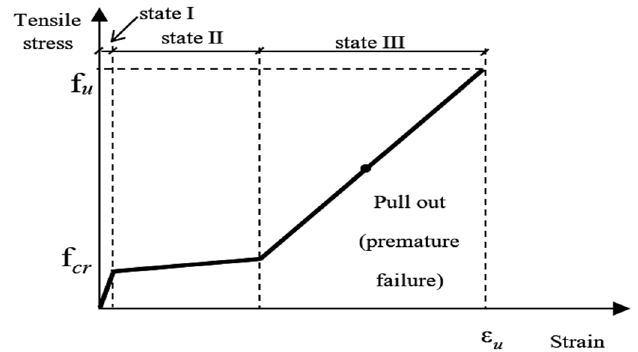
Figure 10. Typical stress–strain relationship of TRC [40].